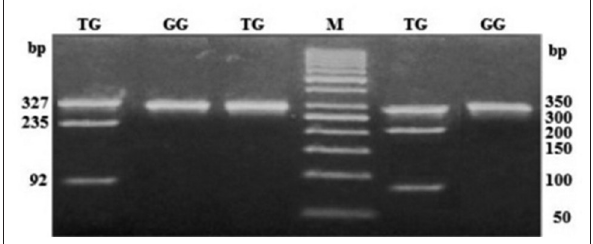
Figure-2: Polymerase chain reaction-restriction fragment length polymorphism profile